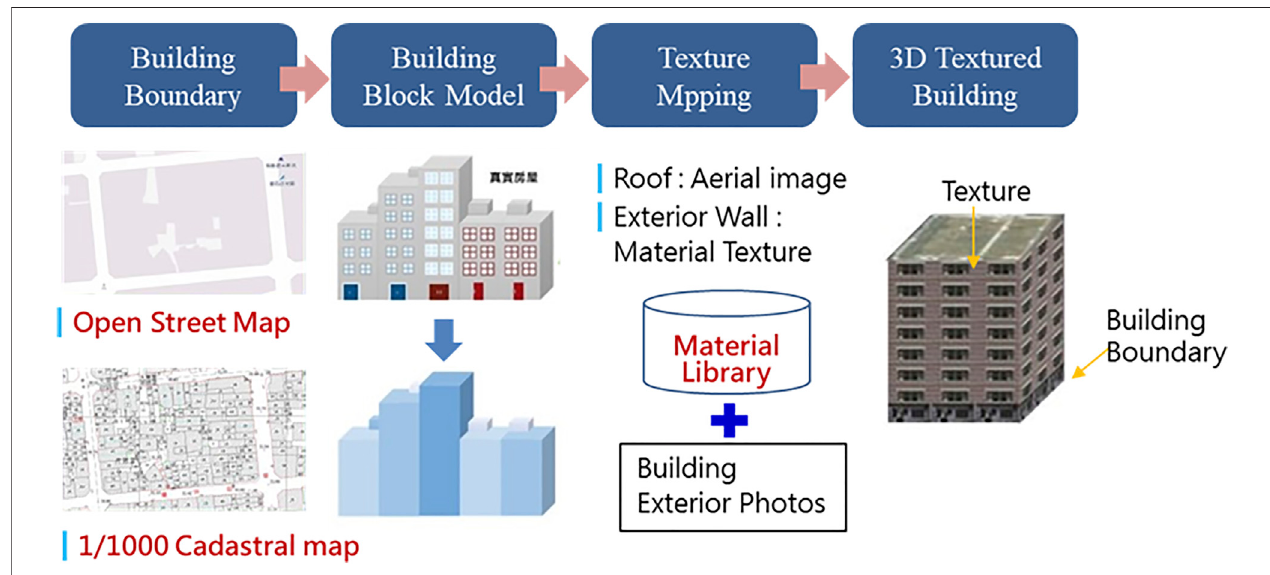
FIGURE 5 | Construction of a 3D building model.